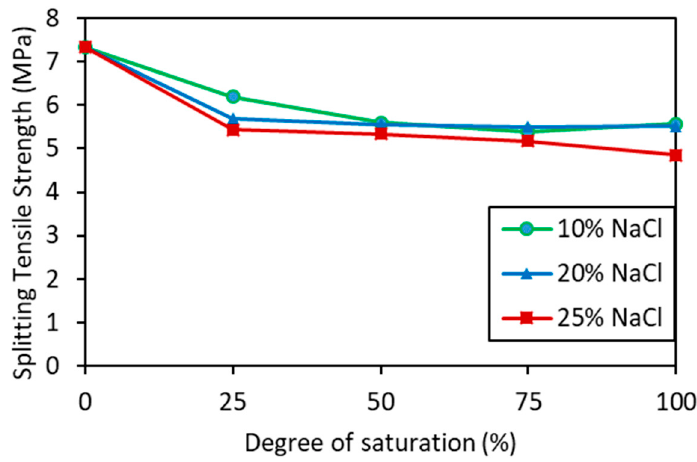
Figure 7. Variation of splitting tensile strength of siltstone in 10%, 20%, and 25% NaCl.